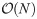
Validation.(A) Simulated activity of N = 500 neurons organized in A = 5 assemblies. Time sequences of length M = 1000 for all neurons have been generated from the model with λμ(0) = 0.08, λμ(1) = 0.6 and pμ = 0.1 for asynchrony, synchrony and activity equal for all assemblies. We used this activity matrix as input to our inference algorithm to recover the five assemblies. (B) (top) log-likelihood over the course of 300 iterations of the Monte Carlo sampler and (bottom) number of transitions per iteration divided by the number of neurons N (different colors correspond to different initializations of neuronal memberships). (C) Assignments of cells to assemblies at four stages of the sampling. Cells initially assigned to O(N) assemblies are progressively grouped until the original assemblies are recovered.